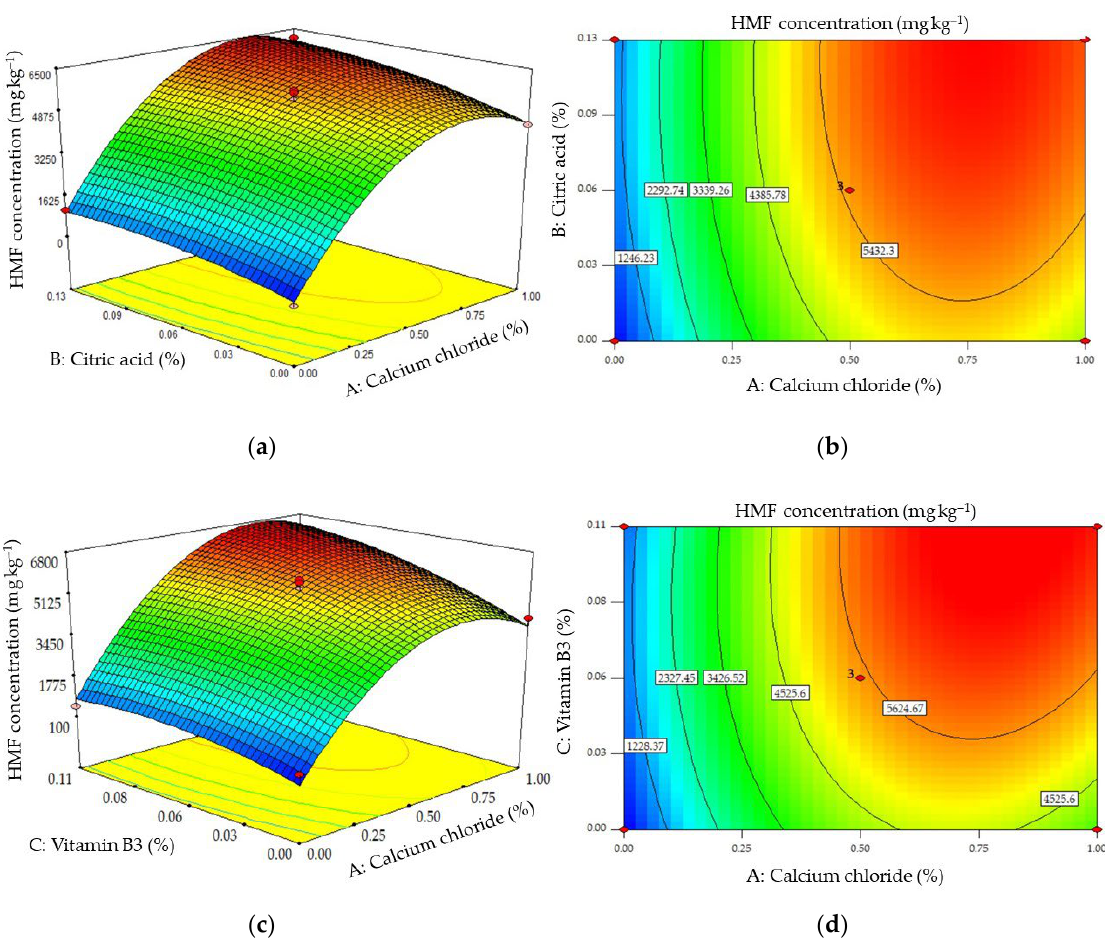
Figure 6. Response surface ( a , c ) and contour ( b , d ) plots of the effects of pairs of additives on the